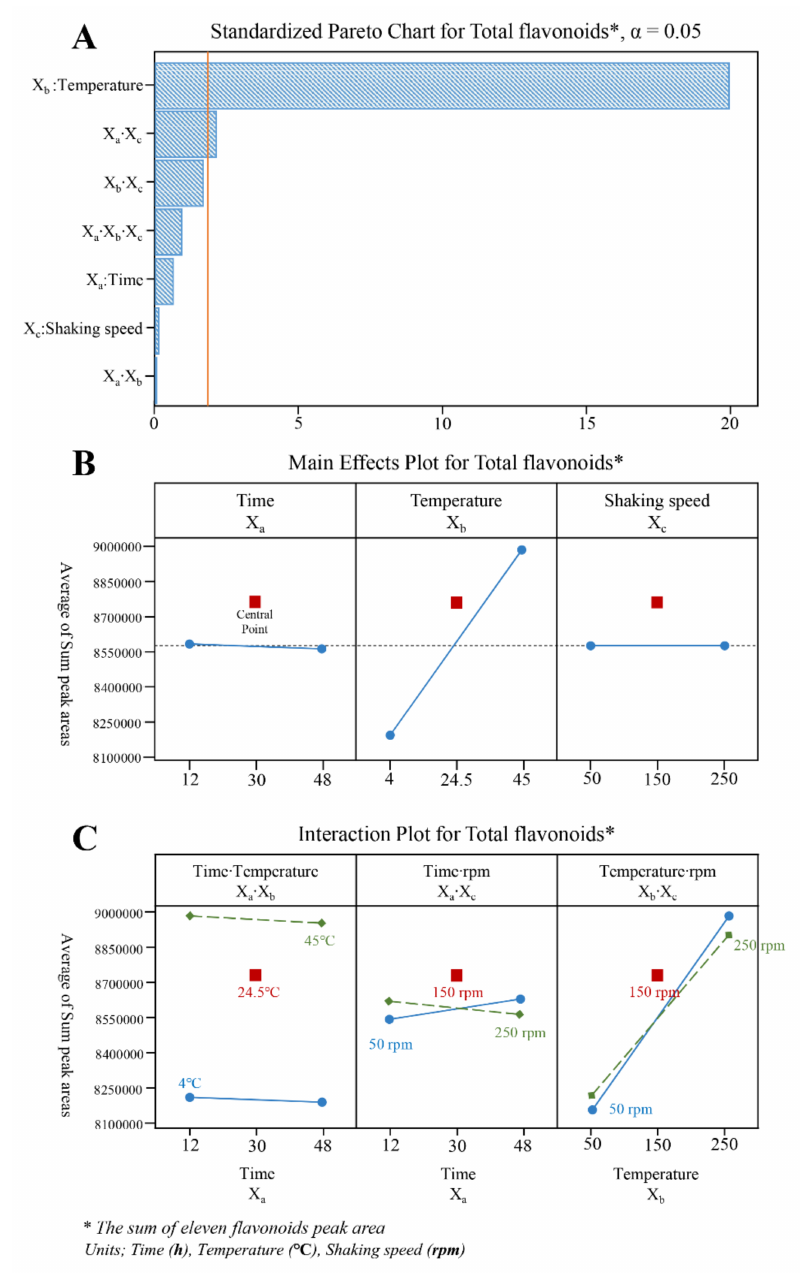
Figure 4. ( A ) Pareto Chart, ( B ) Main Effects Plot, and ( C ) Interaction Plot in 2 3 FFD for optimization of flavonoids shaking extraction